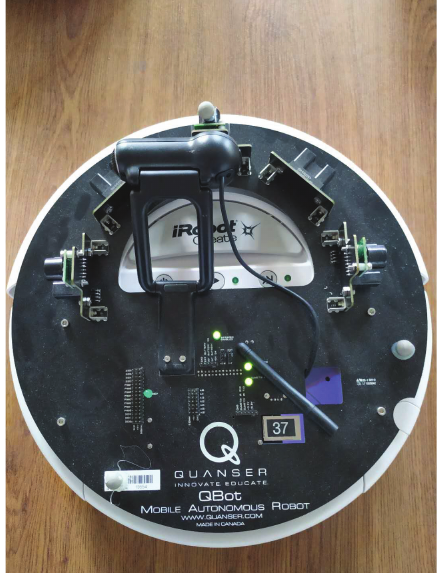
Figure 2. The Qbot